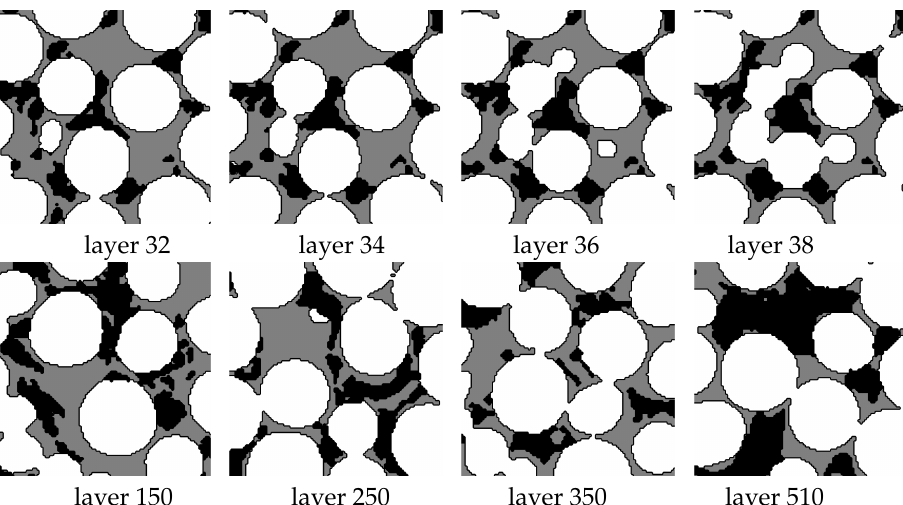
Figure 2. Pore-scale data with obstructions present with data from [6] on biofilm. All images are at resolution 204 × 204. Region D v is in black, D r in white, and D o in gray. Shown are horizontal slices of column data for different layers, layer 34, which is identical to (a) in Figure 1. The original porosity φ 0 ≈ 0.44 for this layer is decreased to φ ≈ 0.157 with the corresponding relative volume of obstructions V o ≈ 0.648.The obstructions are pore-coating at lower V o as well as when vertical slices are